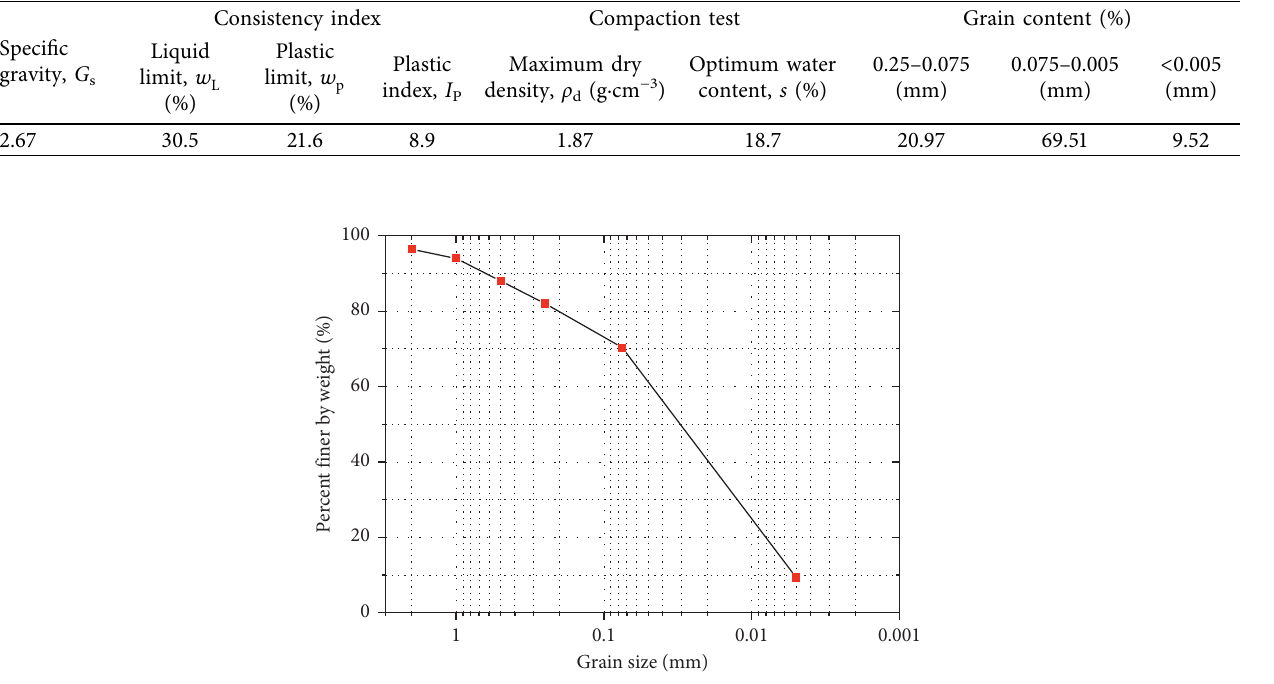
Figure 2: Grain size distribution curve. Table 2: Ion content of saline soils (mg).